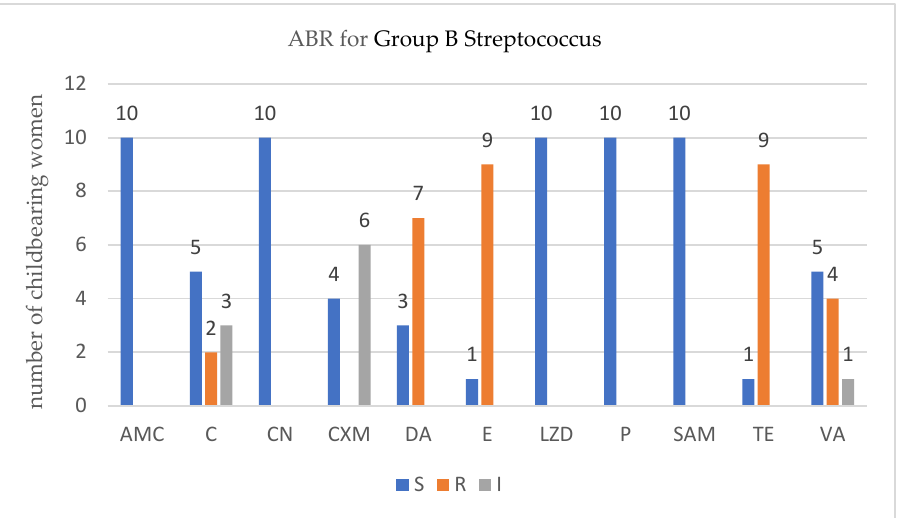
Figure 4. Profile of antibiotic resistance for Streptococcus group B. ; S = sensitive, I = intermediate; R = resistant. Legend: ampicillin/sulbactam (SAM), amoxicillin/clavulanic acid (AMC), chloram- phenicol (C), cefuroxime (CXM), clindamycin (DA), erythromycin (E), gentamycin (CN), linezolid (LZD), penicillin (P), tetracycline (TE), and vancomycin (VA).